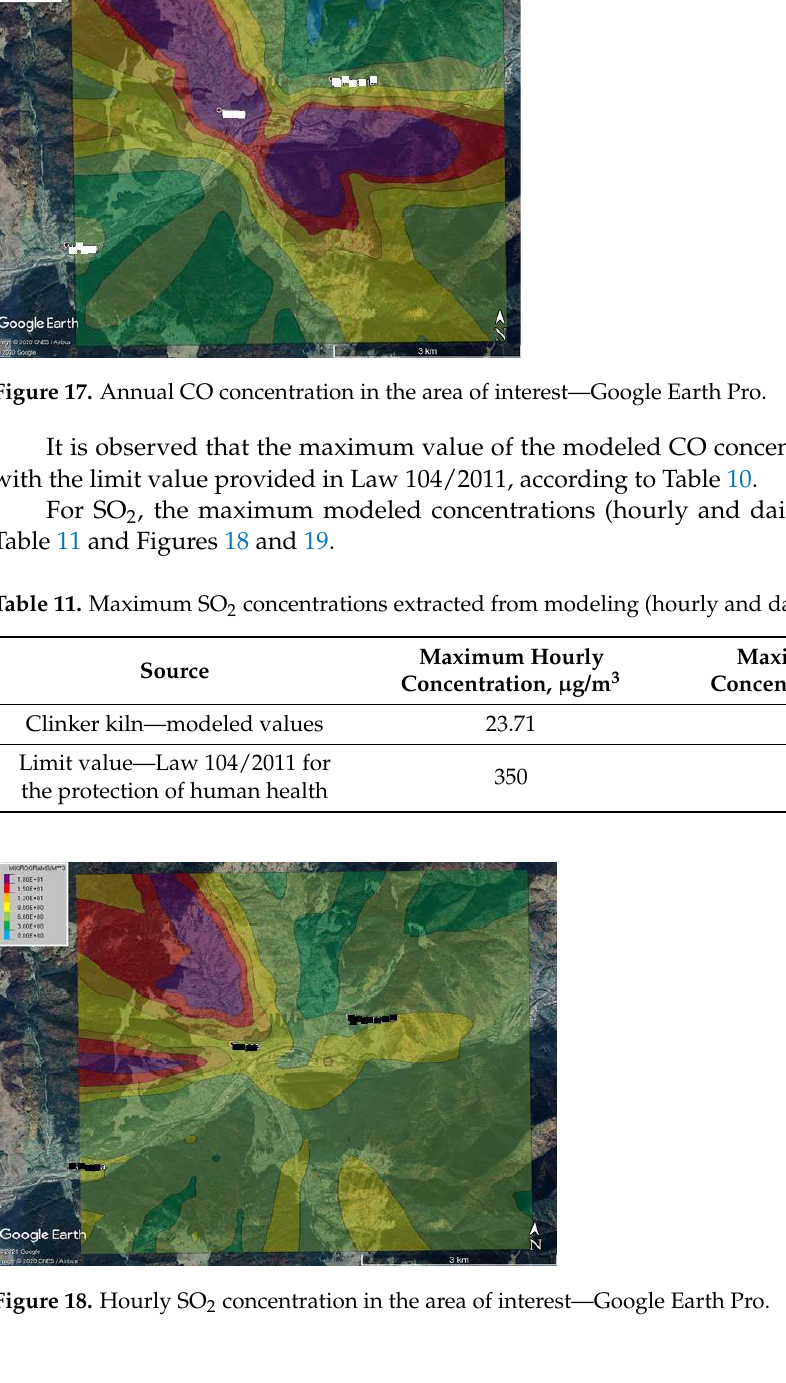
Figure 18. Hourly SO 2 concentration in the area of interest—Google Earth Pro.